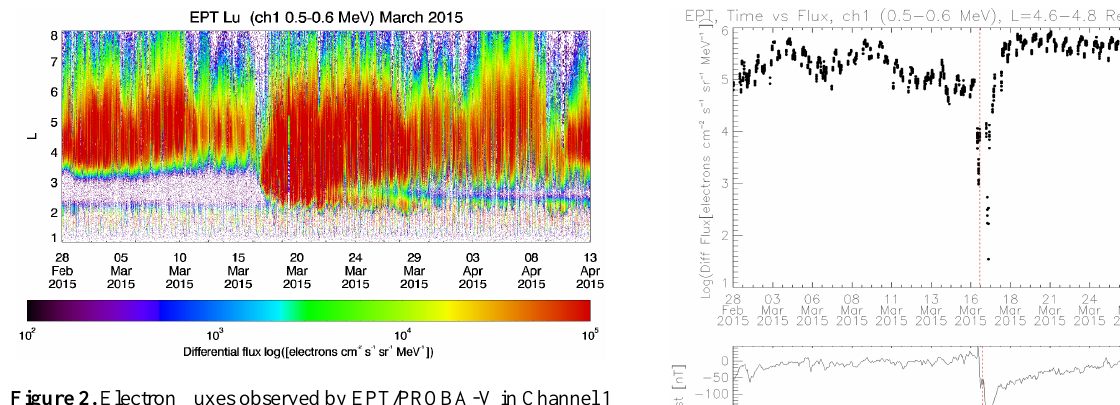
Figure 2. Electron fluxes observed by EPT/PROBA-V in Channel 1 (500–600keV) as a function of L between 28 February and 13 April 2015.